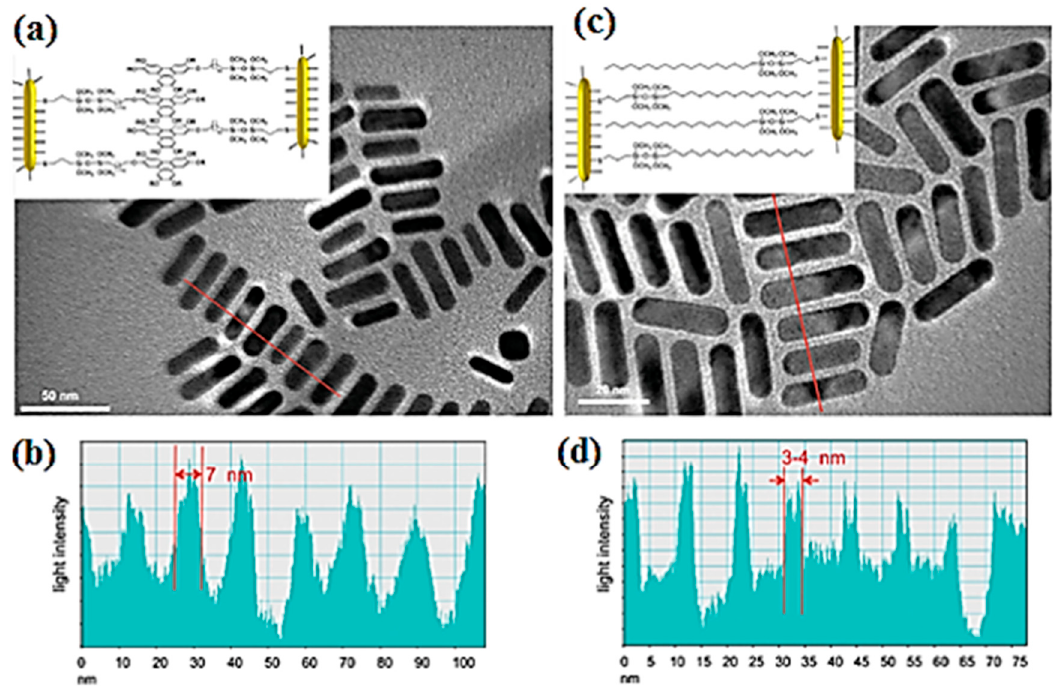
Figure 4. ( a ) TEM image of the DLC-GNRs; ( b ) Cross section profile of ( a ); ( c ) TEM image of the ODS-GNRs; ( d ) Cross section profile of ( c ). Insets show the arrangement of the GNRs in each case. Reproduced with permission [91].